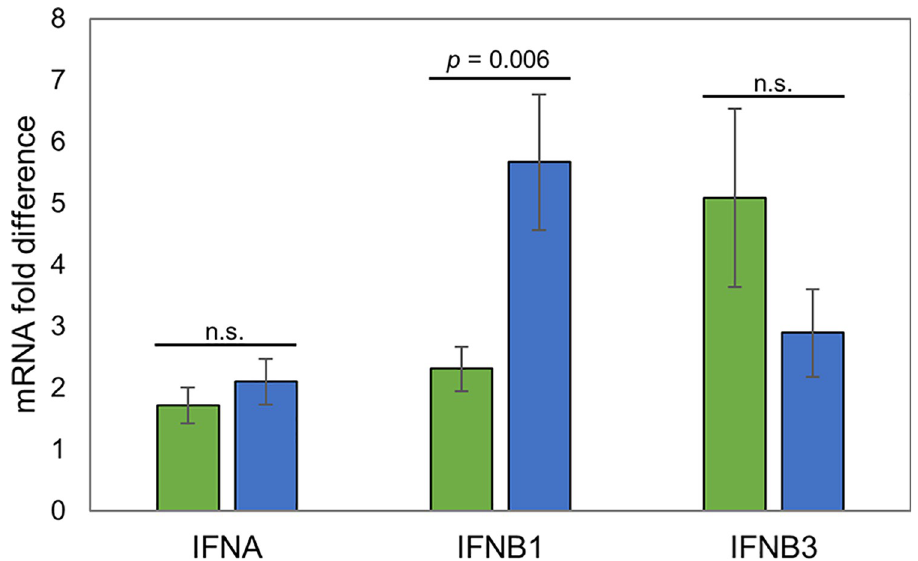
Fig 6. qRT-PCR analysis of INF genes: INFA , INFB1 and INFB3 . The Y-axis shows mRNA fold difference (calculated vs . the lowest expressed sample): Green infill designates, Sahiwal; blue infill, Holstein. Degree of significance denoted above